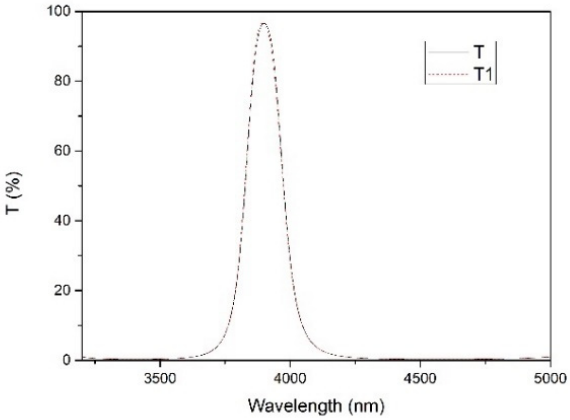
Figure 5. Comparison of design curve and test curve based on the Noble IR optical monitor.